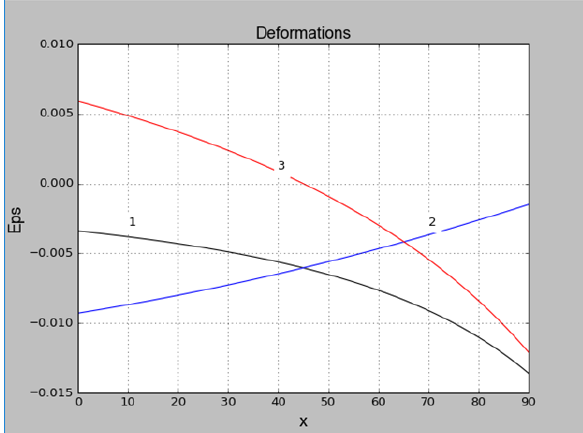
Figure 3: The distribution law of deformation: 1 - ϵ ( x ) ; 2 – ϵ T ( x ) u 3 – ϵ x ( x ) .